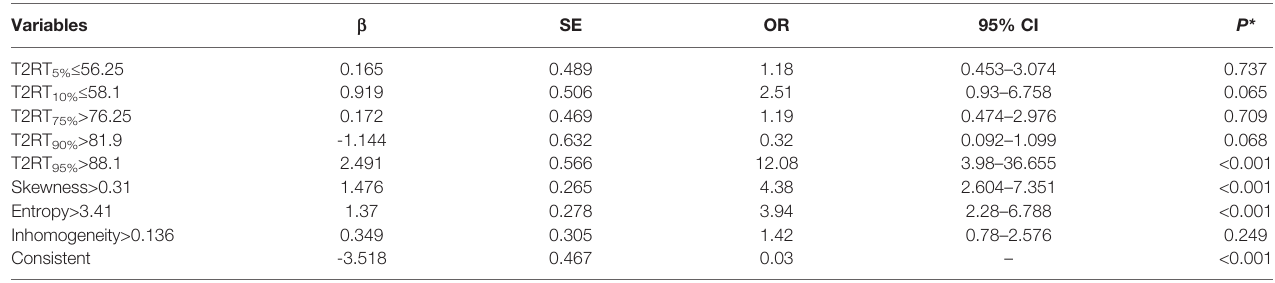
b , coef fi cient from binary logistic regression model. OR, odds ratio; SE, standard error; CI, con fi dence interval. T2RT, T2 relaxation time. The unit of T2RT is